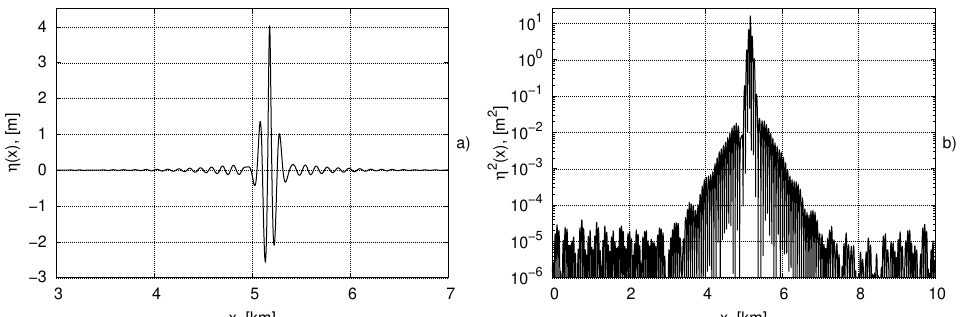
Figure 7. Profile of η ( x ) ( a ) and η 2 ( x ) in log scale ( b ) for bound structure obtained in the model of RV equations with µ fin ≈